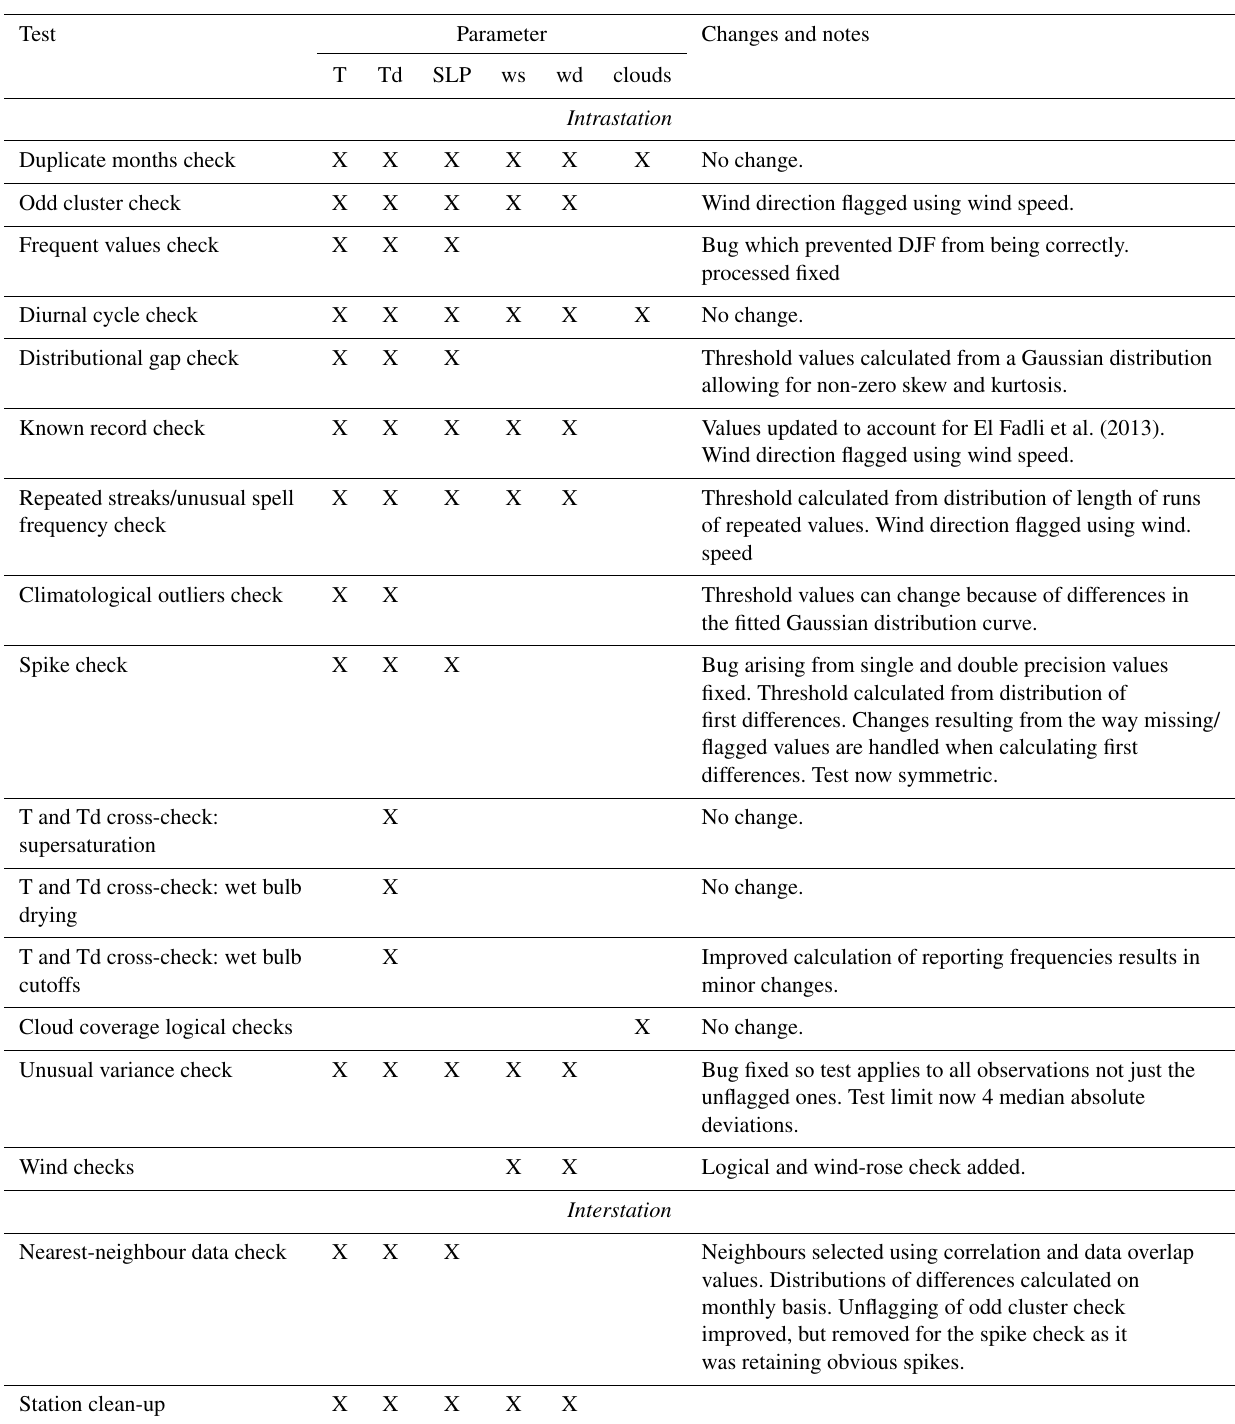
Table A1. Summary of changes in